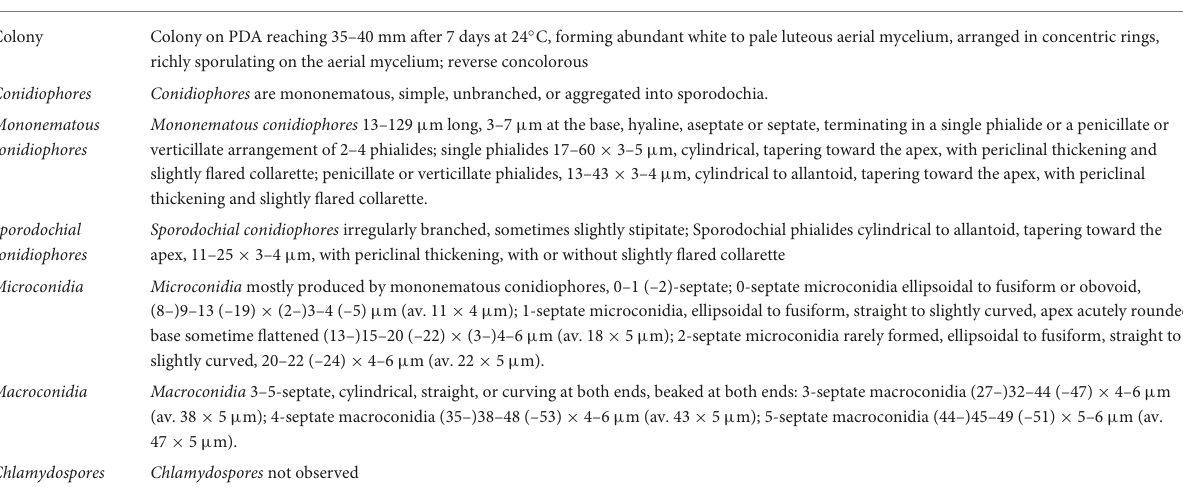
TABLE 2 Morphological characteristics of N. rubicola .